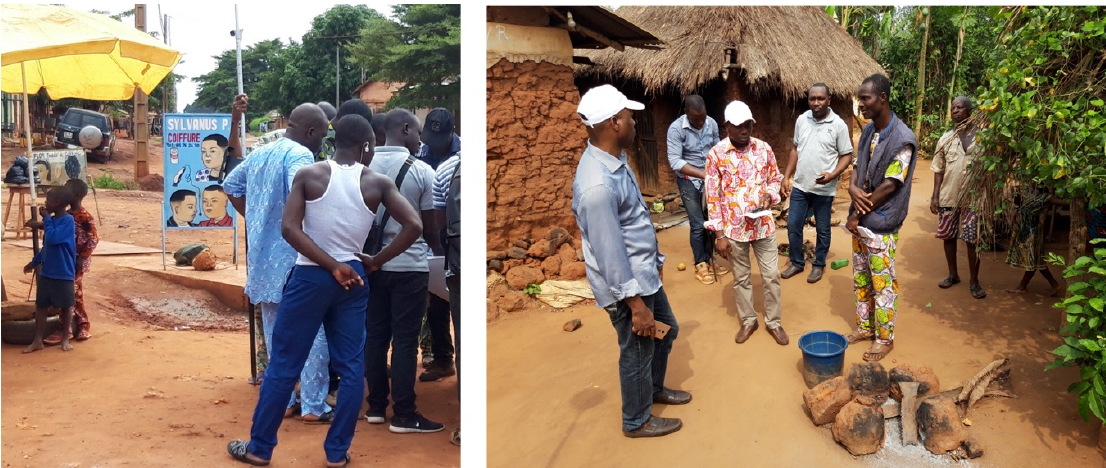
Figure 2. Test site in Bohicon (urban) and in Tori Bossito (rural).